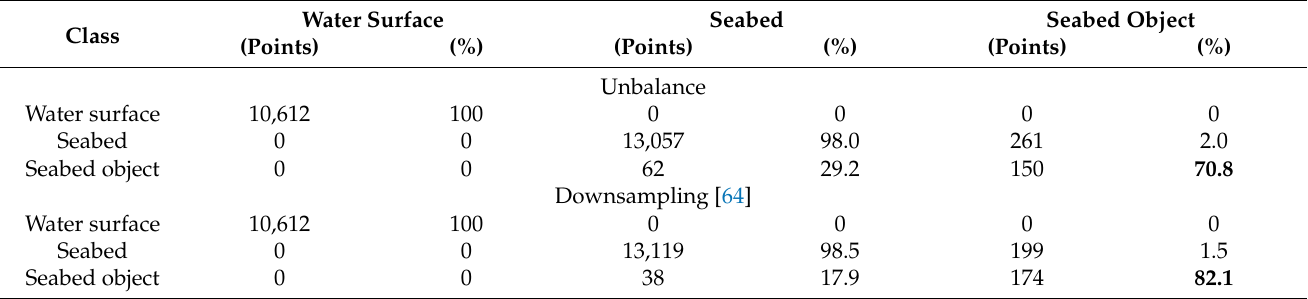
Table 4. Confusion matrix of unbalanced data and data with downsampling.